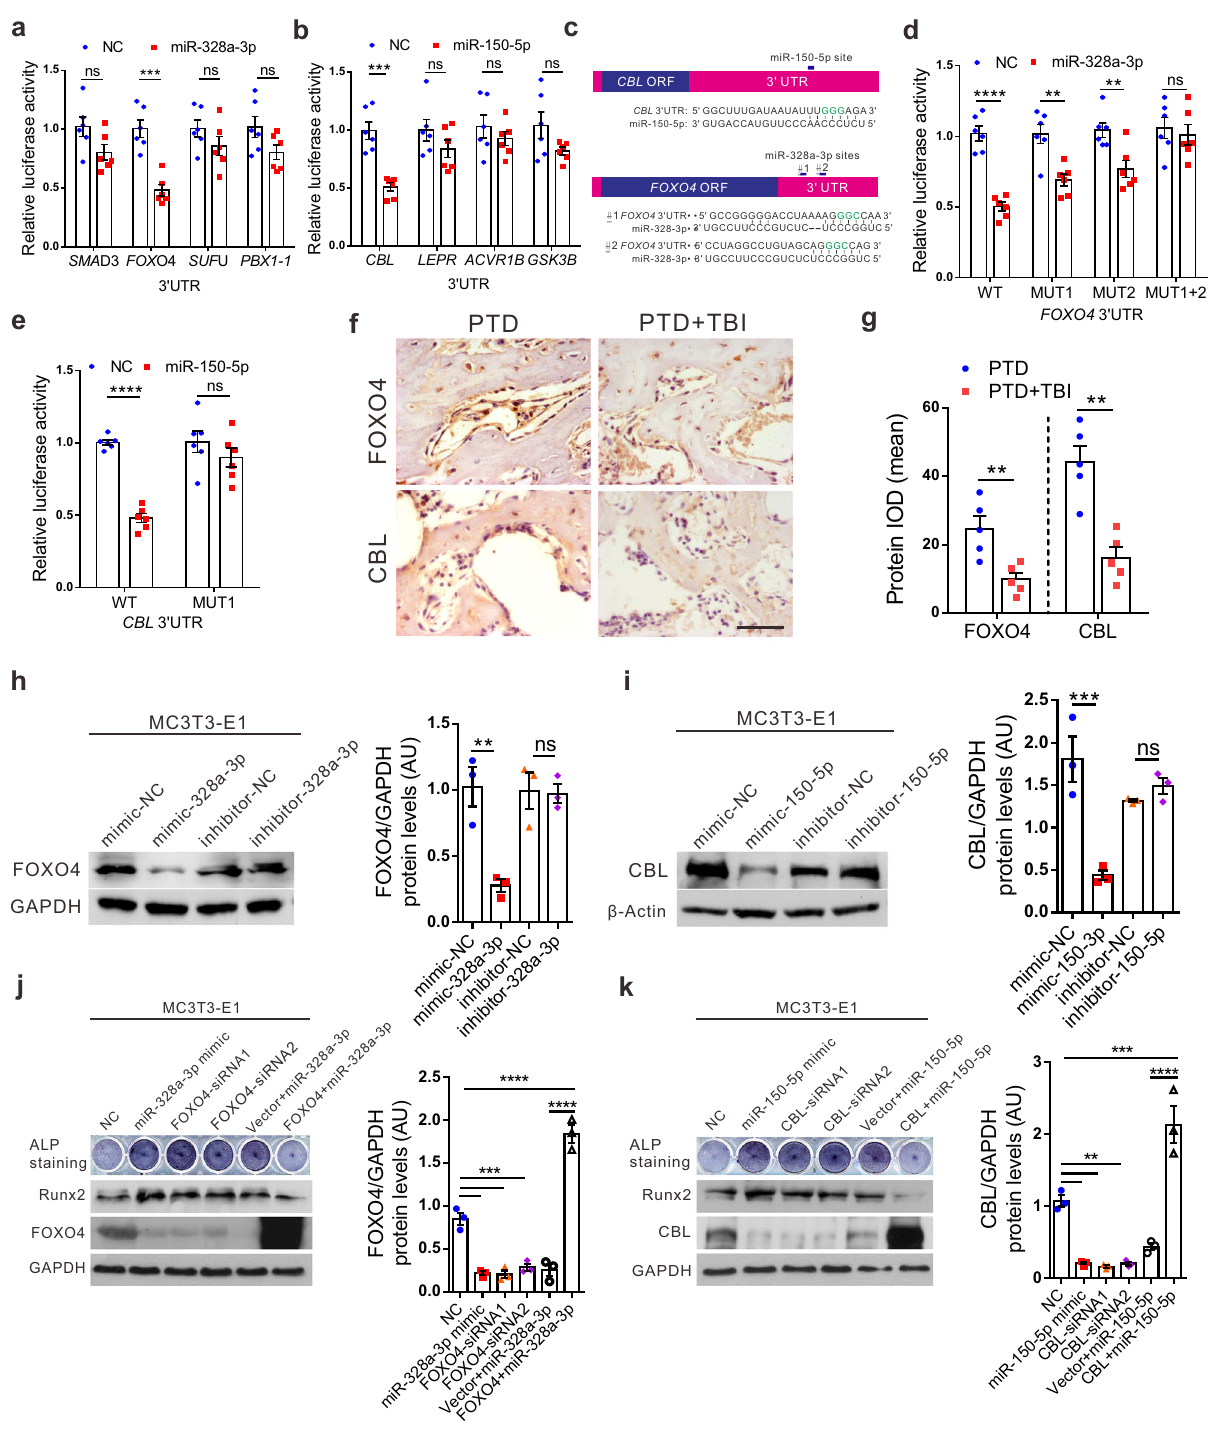
A2M protein in sEVs from TBI rats (Fig. 6b, c and